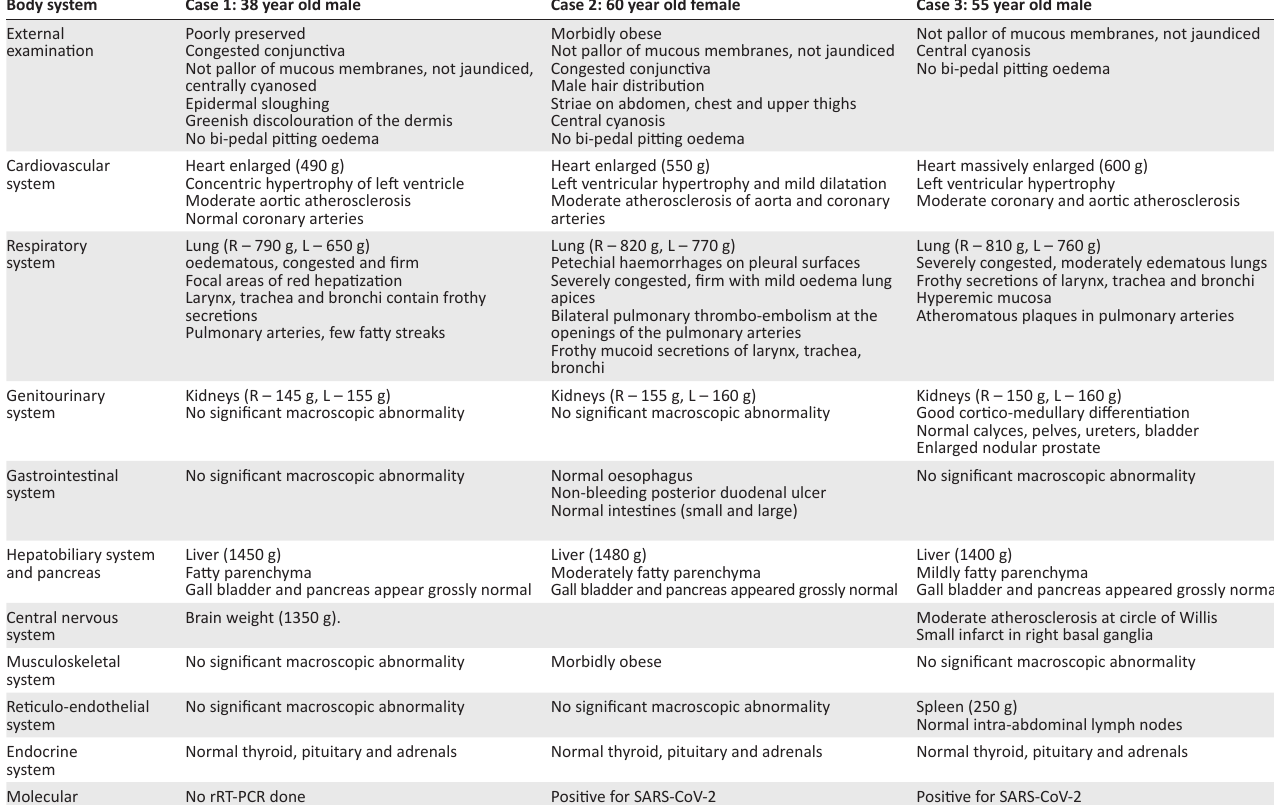
TABLE 1: Autopsy findings of three presumed COVID-19 cases at the 37 Military Hospital, Accra, Ghana, April 2020 to May 2020. Body